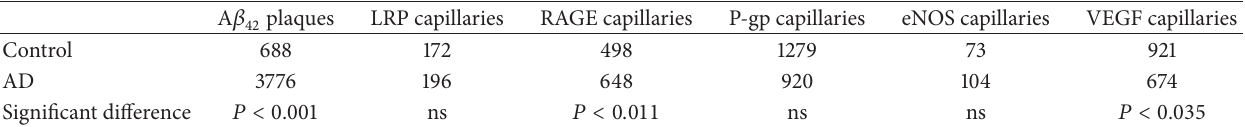
Table 2: Summary of raw data and significant difference results.